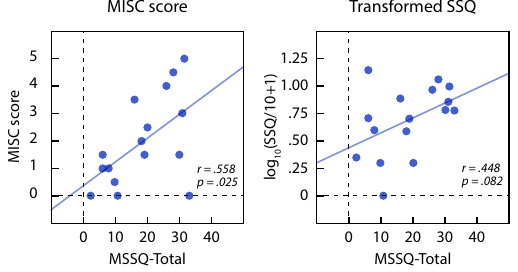
Fig. 7 Cybersickness experienced by individual subjects in Experiment 1 plotted as a function of self-reported motion sickness susceptibility (MSSQ total). Lines show the regression fits. The left graph plots the MISC scores and right graph plots the SSQ after transforming by log 10 (SSQ/10 +